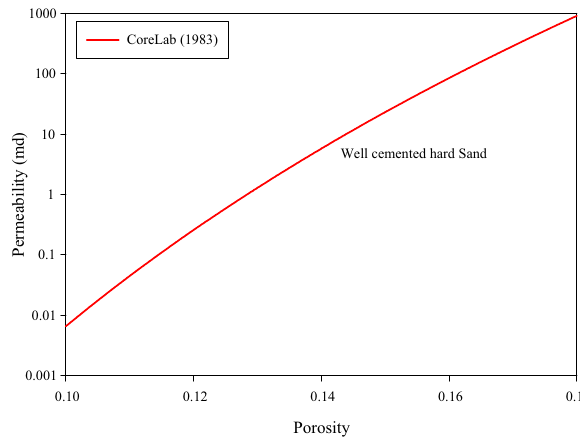
Fig. 2 The correlation between horizontal absolute permeability and porosity (Tiab and Donaldson